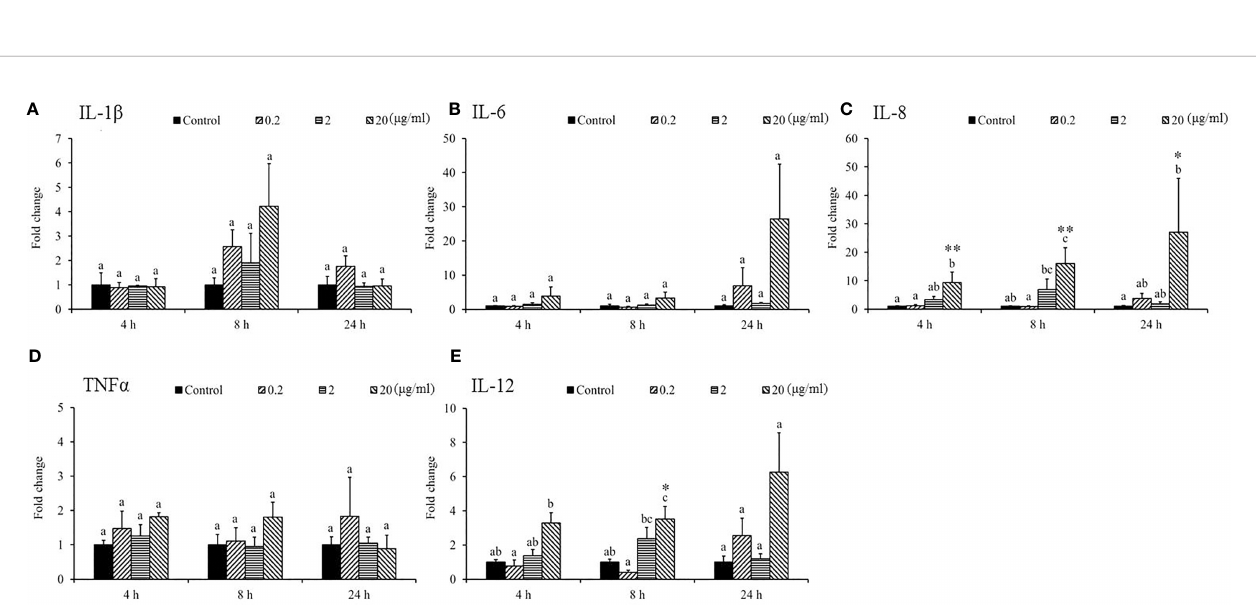
IgT ( Figure 3E ) were enhanced in the group that received 20 m g of SSWE per gram fi sh body weight (BW) at 8 h. The expression of IL-1 b was under the detection limit in the spleen and was therefore omitted from the analysis. The mRNA levels of proin fl ammatory cytokines, namely, IL-8 ( Figure 4B ),